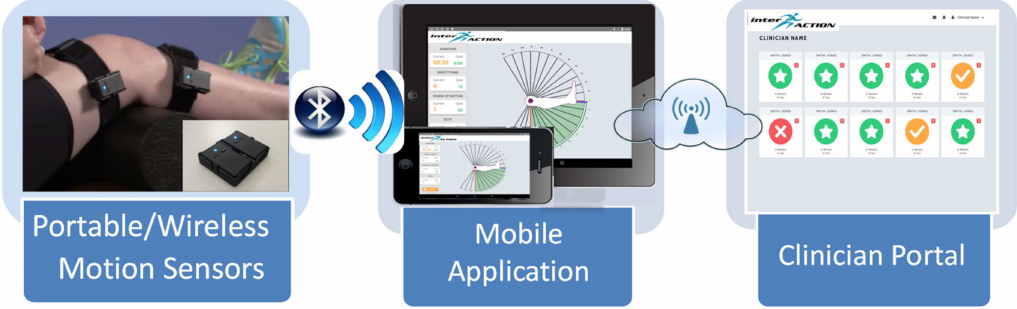
Figure 1. Conceptual flowchart of the interACTION platform: (1) inertial measurement units (IMUs) attached to the patient’s thigh and shank using neoprene straps and 3D-printed cases, (2) mobile application utilized by the patient to complete their prescribed home exercises, (3) screenshot of clinician portal depicting the patient dashboard which is utilized by the physical therapist to manage the patient’s rehabilitation